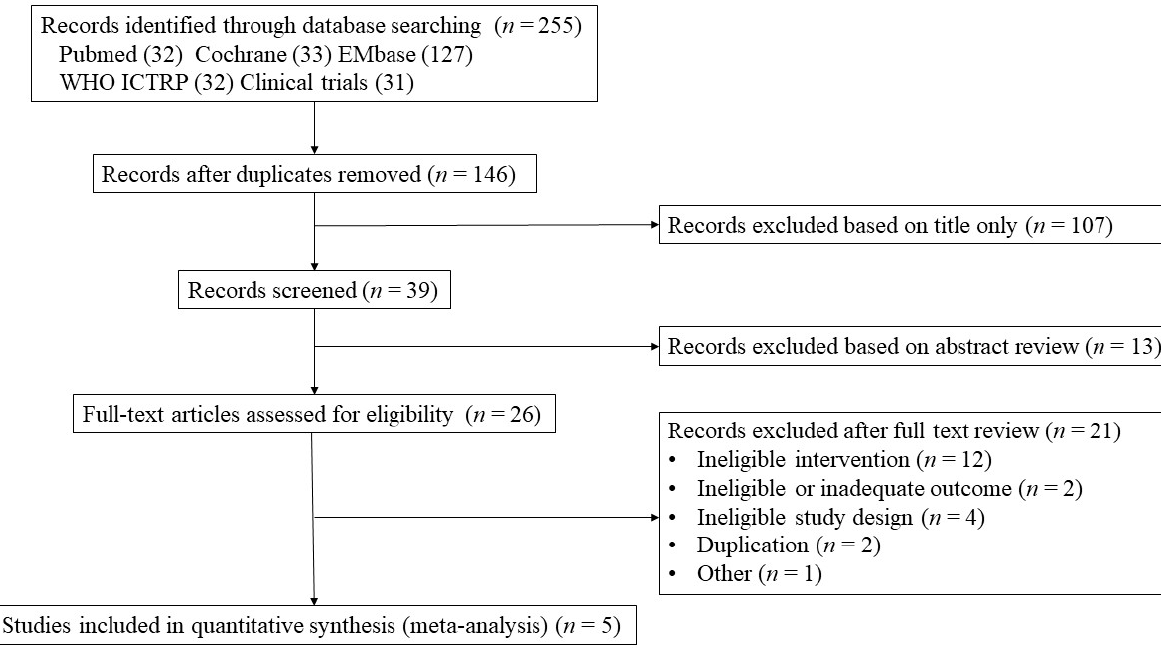
Figure 1. PRISMA flow diagram.